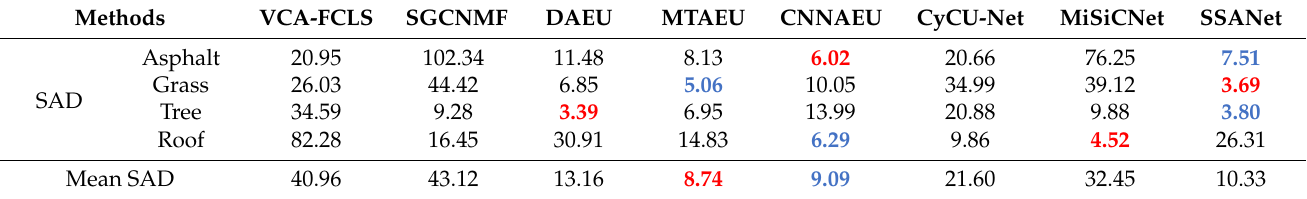
Table 9. SAD ( × 100) and mean SAD ( × 100) of endmembers acquired by different unmixing ap- proaches on Urban data. Annotation: bold red text indicates the best results and bold blue text indicates the suboptimal